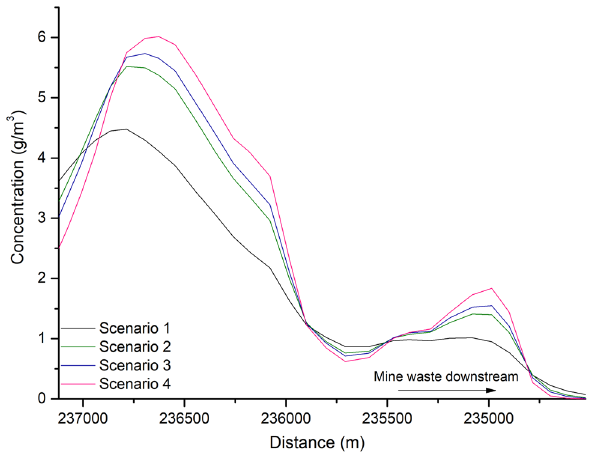
Fig. 12 Simulated sulfate concentration downstream to the mine waste and along the plume axis of the four